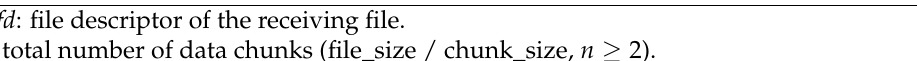
Algorithm 2 Receiver-side